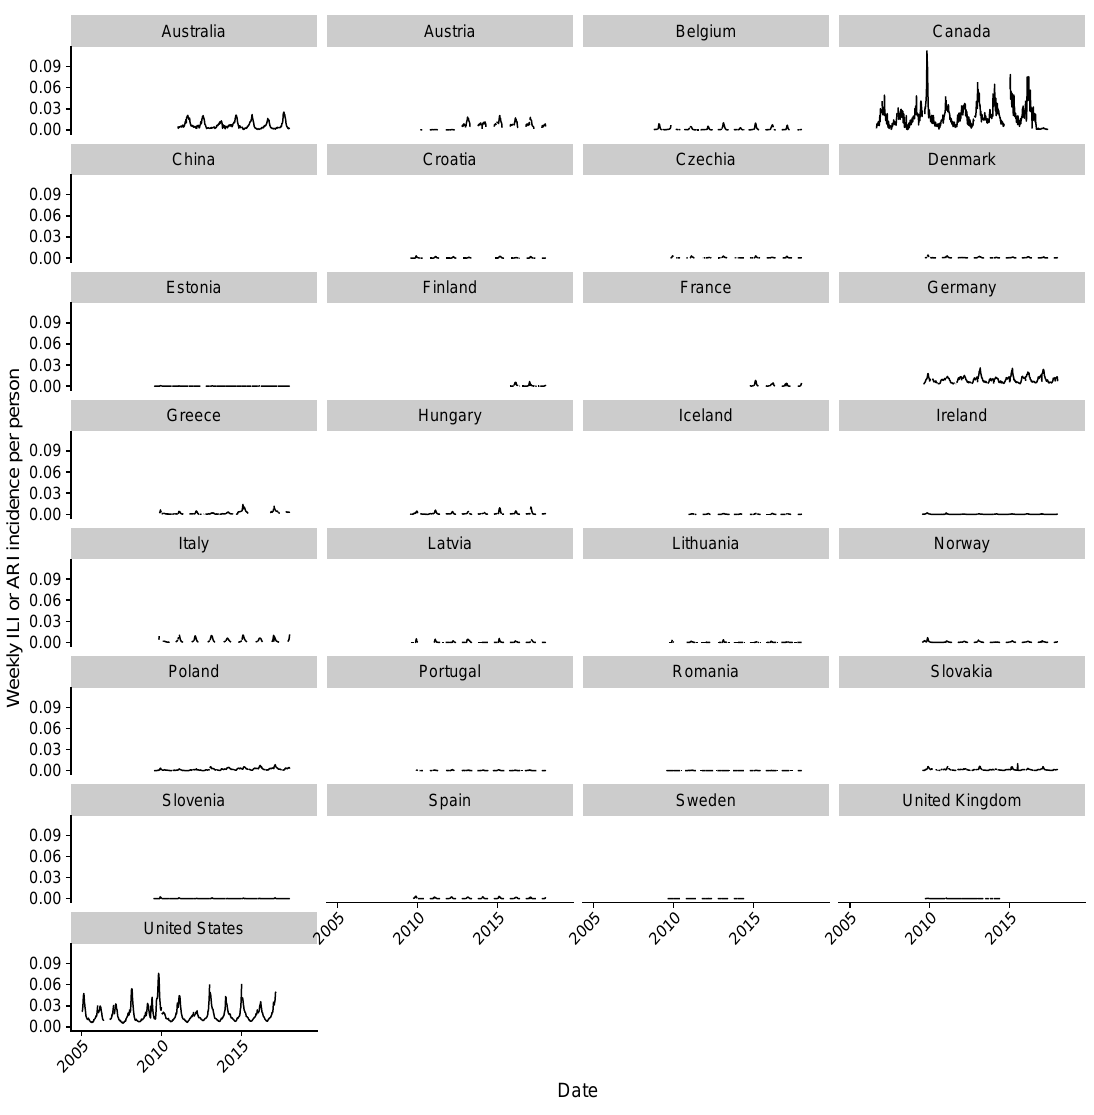
Figure A18. As in Figure A7, but using a fixed y -axis scale for